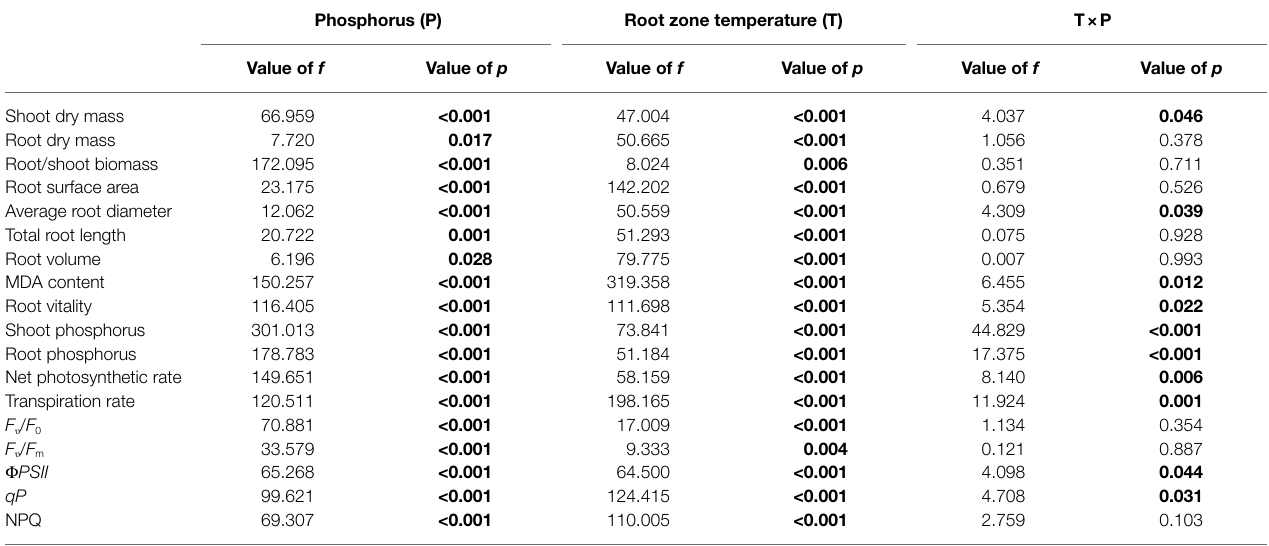
TABLE 1 | Two-way ANOVA of the effects of root zone temperature, phosphorus, and their interaction on maize growth. Phosphorus (P) Root zone temperature (T) Value of f Shoot dry